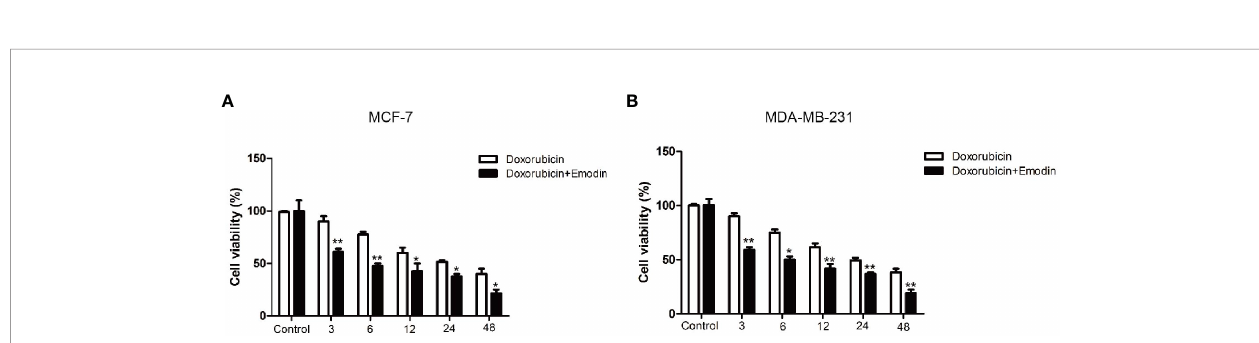
FIGURE 3 | Emodin enhances the sensitivity of BC cells to doxorubicin. (A) BC cells (MCF-7 and MDA-MB-231) were treated with Emodin and Doxorubicin for 48 h. CCK-8 assay shows that Emodin (110 m M) enhances the sensitivity of MCF-7 cells to Doxorubicin. (B) A combination of Emodin (110 m M) and Doxorubicin signi fi cantly decreases the growth of MDA-MB-231 cells compared with single Doxorubicin treatment. ** P < 0.01, * P < 0.05 compare with Doxorubicin group. The analysis was conducted using the Student ’ s